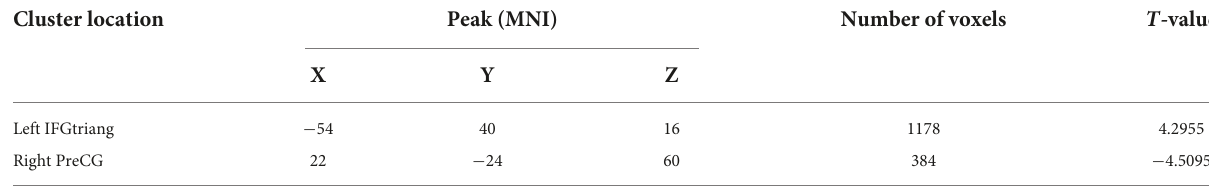
uncorrected p -value at 0.001 was selected as the threshold for statistical significance. The above steps were completed with SPM12. The CBF values of brain regions showing differences were extracted with dpabi4.3 before visualizing